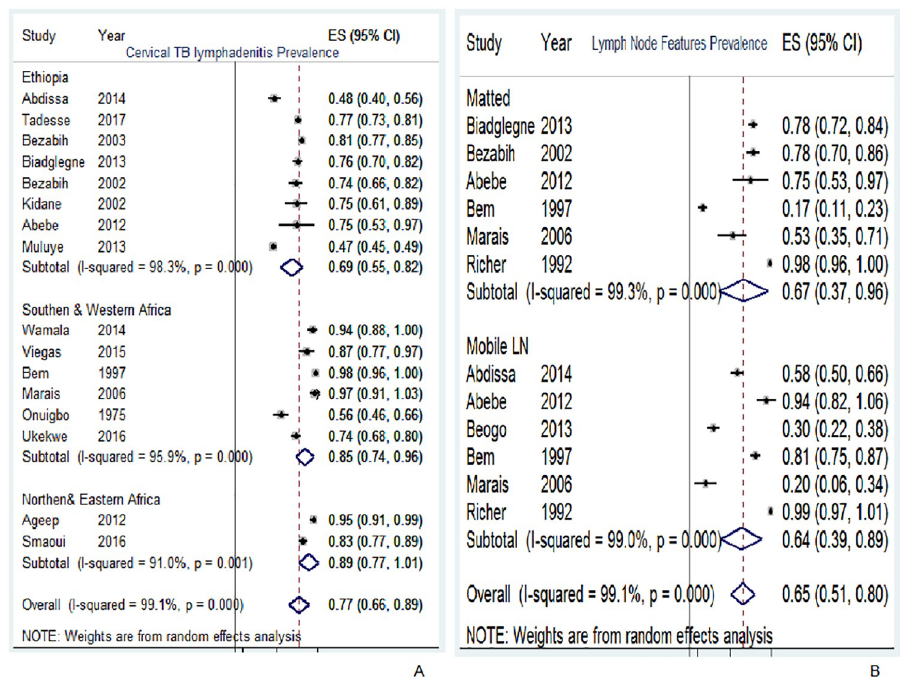
Fig 3. Pooled prevalence of TBLN types and features, Africa, 1970–2015.